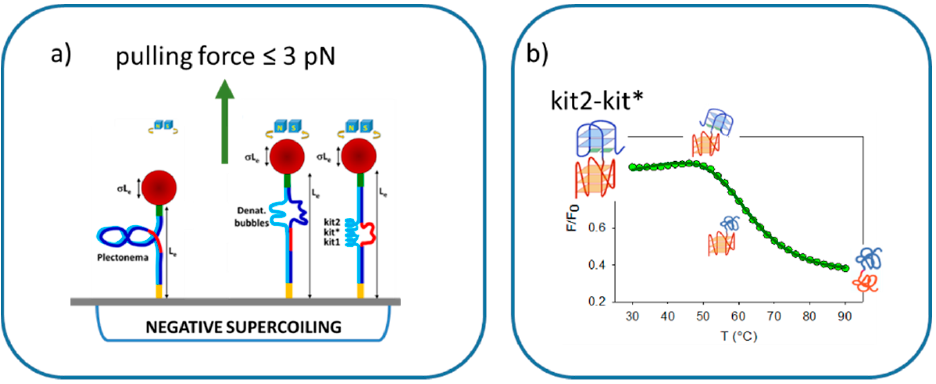
Figure 5. Multiple G4s at the KIT promoter: ( a ) model of the magnetic tweezer approach used to monitor G4 formation (adapted from [59]) and ( b ) proposed unfolding pathway of the kit2-kit* fragment (adapted from [60]).